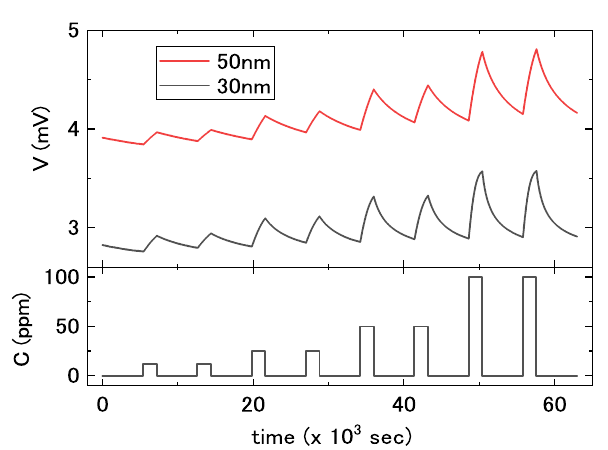
Figure 3. Responses of PdCuSi/MSS to hydrogen concentrations of 12, 25, 50, and 100 ppm. Their baselines are not corrected (no offset). Horizontal axis represents time, and vertical axes represent the signals of the MSS (V) and the concentration of hydrogen (C) regulated by the mass-flow